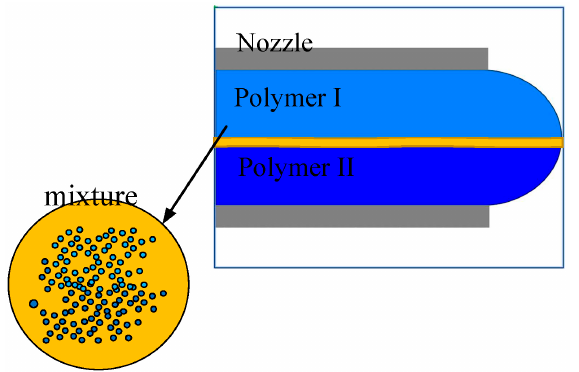
Figure 3. Schematic diagram of two-phase mixed layer.